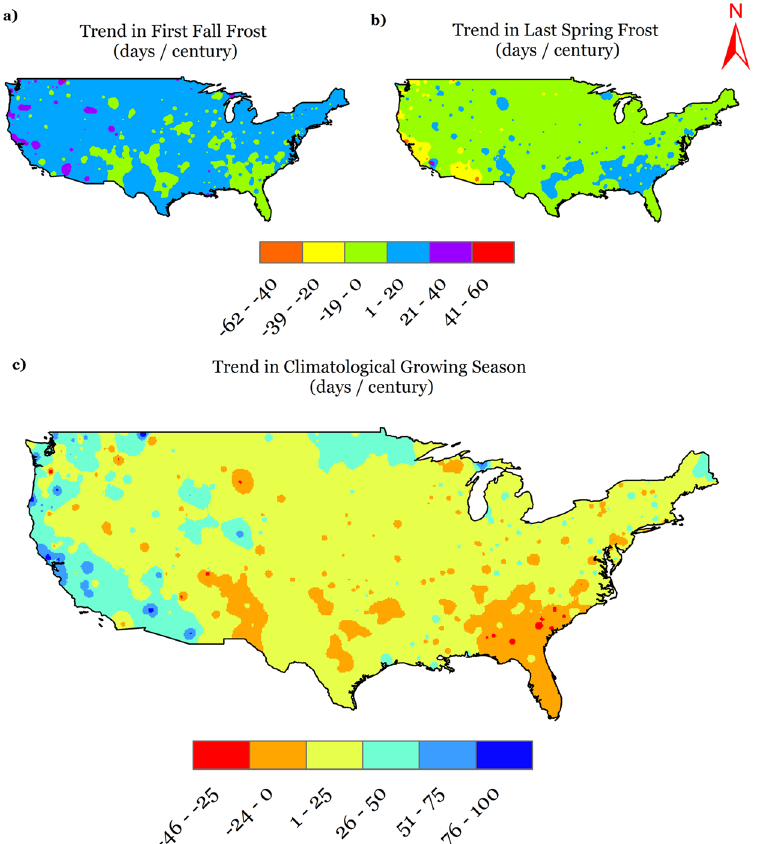
Figure 6. Temporal trends in ( a ) first fall frost (FFF); ( b ) last spring frost (LSF), and ( c ) climatological growing season (CGS) across CONUS during 1900–2014. We created the maps using ESRI ArcMap 10.4.1